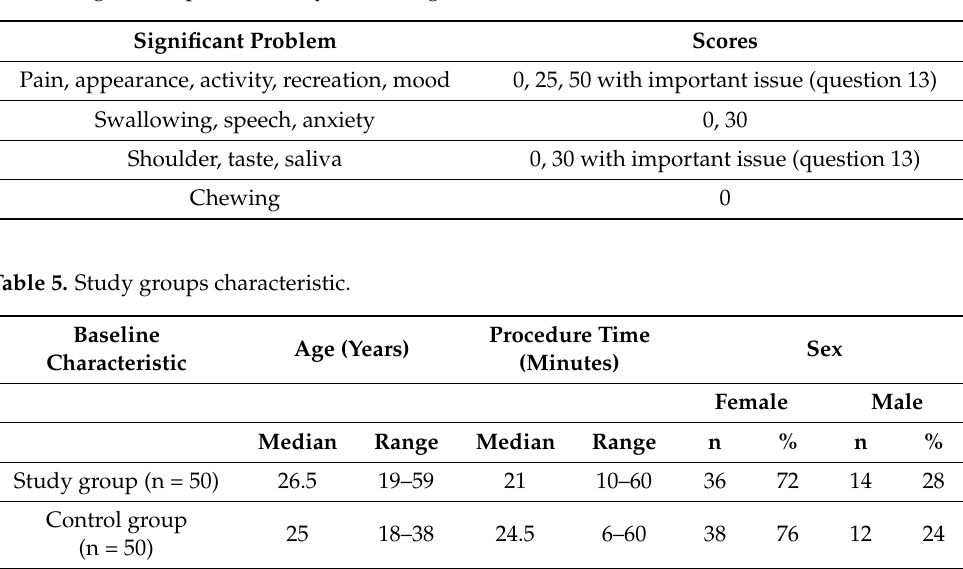
Table 4. Significant problem—key for scoring [18].